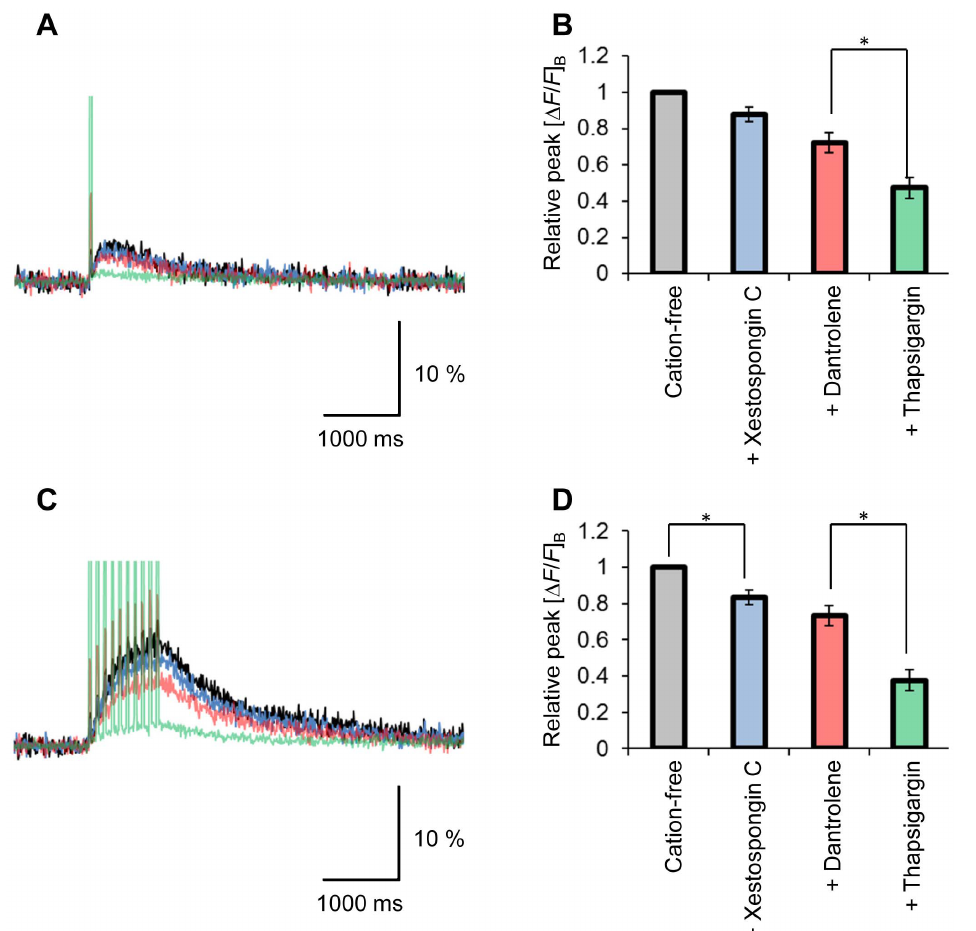
Figure 7. Involvement of Ca 2 + store. A , Typical [ D F/F ] B response of a calyx to a single 20 ms laser pulse in the cation-free extracellular solution (black), the response with additional xestospongin C (blue), the response with additional dantrolene (red) and the response after repetitive photostimulation with additional thapsigargin (green). Each trace is an average of five consecutive records. B , Summary of peak [ D F/F ] B changes (mean 6 SEM) in the cation-free solution. Each column indicates the relative value to that without any pharmacological reagents. *, P , 0.05 (n=7). C , Sample [ D F/F ] B responses of the same presynaptic terminal as shown in A , but in response to a train of electrical stimulations (10 Hz, 1 s); without any pharmacological reagents in cation-free solution (black), with additional xestospongin C (blue), with additional dantrolene (red) and after repetitive photostimulation with additional thapsigargin (green). Each trace is an average of five consecutive records. D , Summary of peak [ D F/F ] B responses to a train of electrical stimulations (10 Hz, 1 s) (mean 6 SEM) in the cation-free solution. Each column indicates the relative value to that without any pharmacological reagents. *, P , 0.05 (n=7). Note in A and C that the artifactual fluorescence was increased during photostimulation after treatment with dantrolene, which emits green-yellow fluorescence